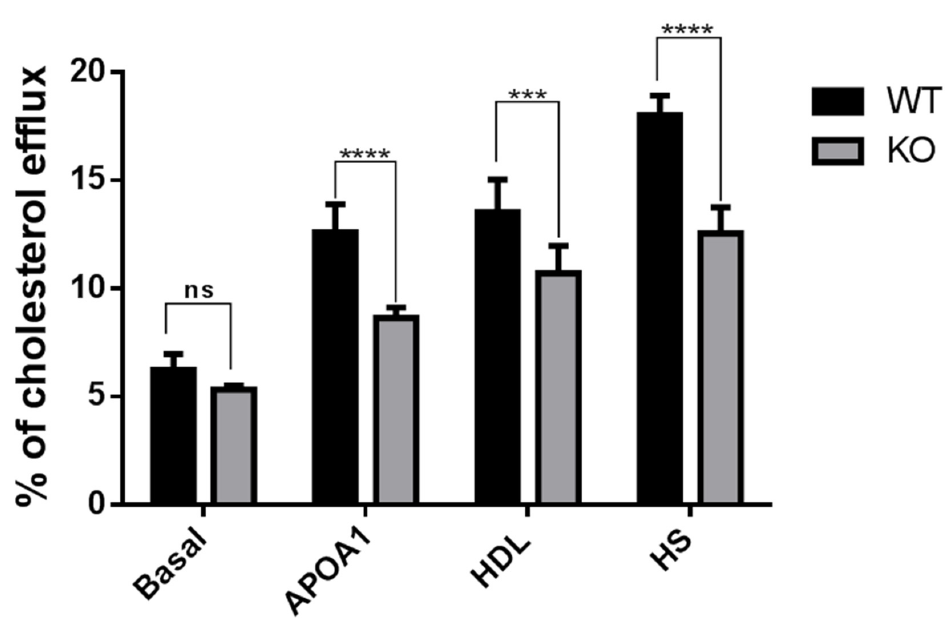
Figure 2. Decreased cholesterol efflux in Tspo KO mouse RPE cells. Primary RPE cell derived from wildtype (WT) and Tspo KO mice at 6 months old were labelled with 0.5 lCi/mL [ 3 H]cholesterol for 24 h followed by 24 h incubation with or without apolipoproteins A–I (ApoA-I, 10 µg/mL), HDL (20 µg/mL) and human serum (HS, 1% v / v ). After incubation, the percentage of [ 3 H]cholesterol efflux was measured. Data were collected from three independent experiments and ana- lyzed by two-way ANOVA followed by Bonferroni test: NS: no significance; *** p < 0.001, **** p < 0.0001.